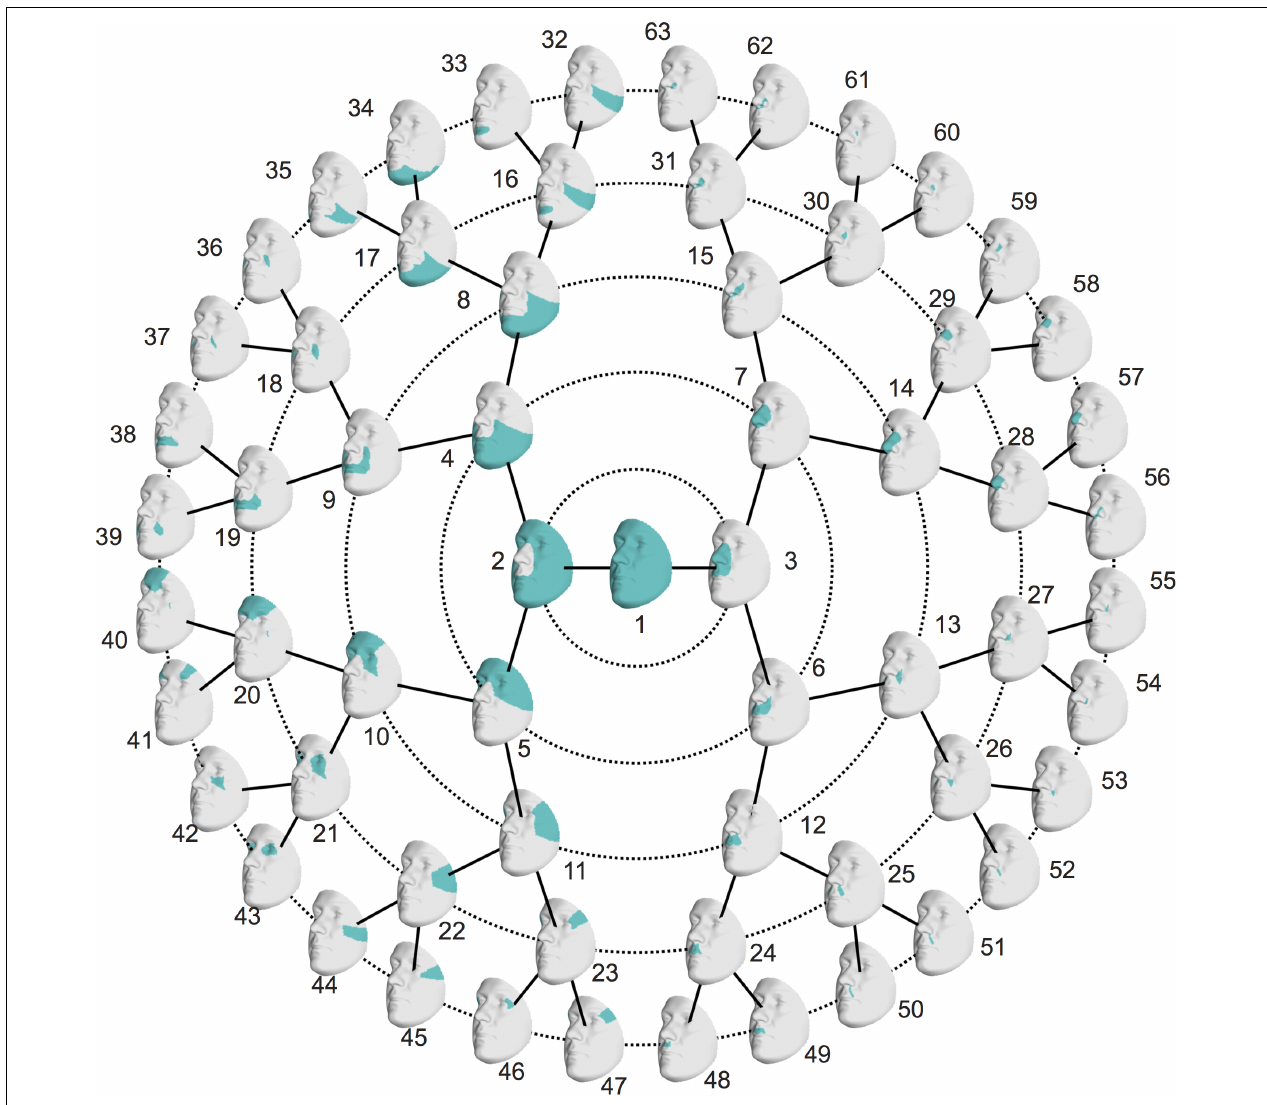
FIGURE 3 | Modules of co-inheritance. Hierarchical facial segmentation of the study cohort, resulting from the grouping of quasi-landmarks with strong co-inheritance ( N = 762 father-offspring pairs). Segments are colored in blue. Facial shape variation is covered at five different levels of detail, with global shape variations located in the center (L 0 ) and local shape variations located towards the outer circle (L 5